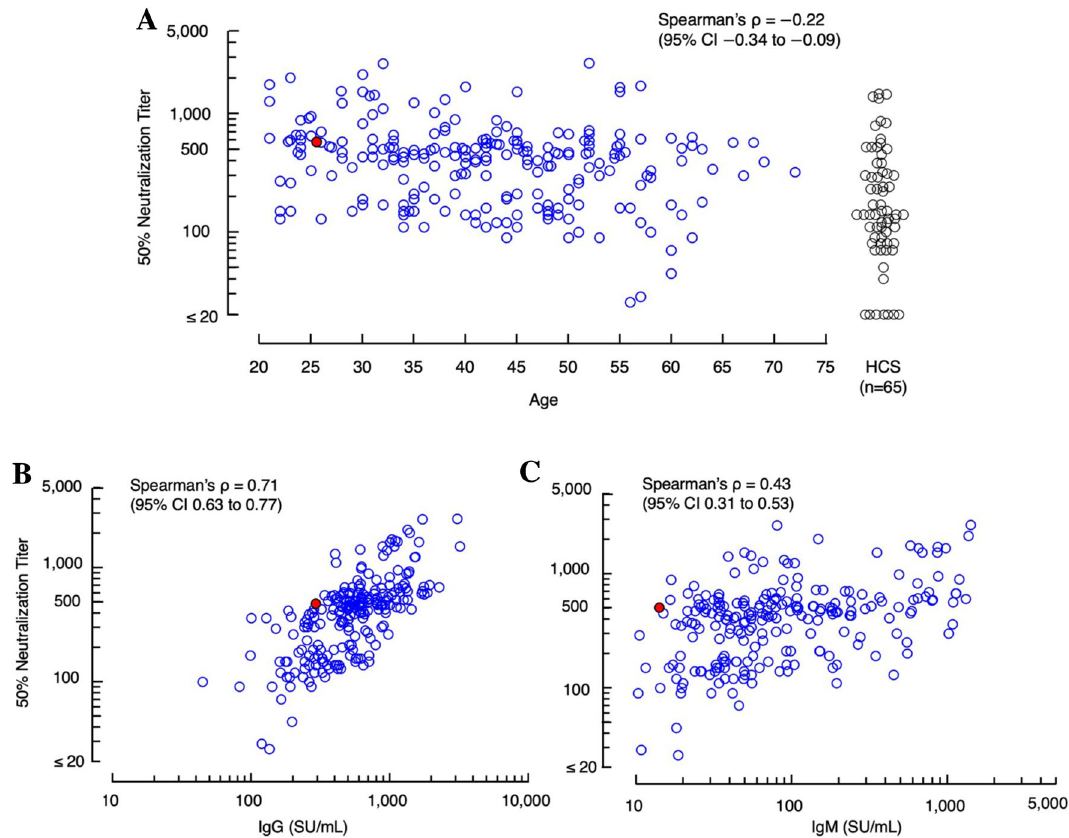
Figure 1. Correlations of neutralizing titers with ages and S1-binding-IgG and -IgM levels. ( A ) Correlation between neutralizing titers (NT 50 s) on day 28 post-1st dose and the ages of the participants (on day 28 post-1st dose). The age range of the study participants was 21–72 (average 41.8 y.o.). A correlation is negligible between NT 50 values and ages (Spearman’s ρ = − 0.22: 95% CI − 0.34 to − 0.09, p = 0.001). The geometric mean NT 50 of the values from all participants (n = 225) was 375.2 (range 25.6–2680), greater by a factor of 2.3 than the geometric mean NT 50 from 65 COVID-19-convalescent patients (geometric mean = 163.0; range 20.0–1470) shown as references on the far right (human COVID-19-convalescent serum: HCS). ( B ) A high correlation is identified (Spearman’s ρ = 0.71; 95% CI 0.63–0.77, p < 0.001) between NT 50 values and S1-binding-IgG levels in samples obtained on day 28 post-1st dose. ( C ) Moderate correlation is seen between neutralizing titers and S1-binding- IgM levels (Spearman’s ρ = 0.43; 95% CI 0.31–0.53, p < 0.001). One participant, who had been infected with SARS-CoV-2 with PCR-positivity documented, is indicated as a solid-red solitary circle. This participant was excluded from all analyses at later